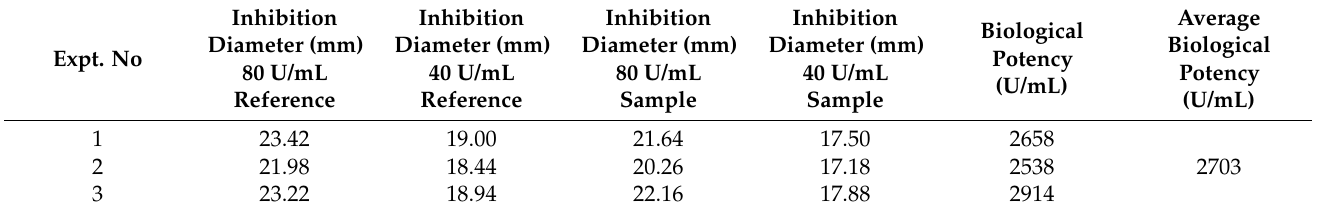
Table 2. Biological potency detection of Streptomyces noursei D-3-14.